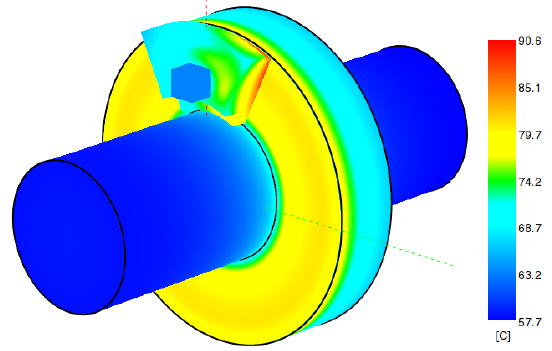
Figure 18: The BEAST model of the tilting pad bear- ing. It consist of three parts; the shaft with collar, the pad, and the pivot support. The surface temperatures are shown. This for a case with 2 MPa load and 3000